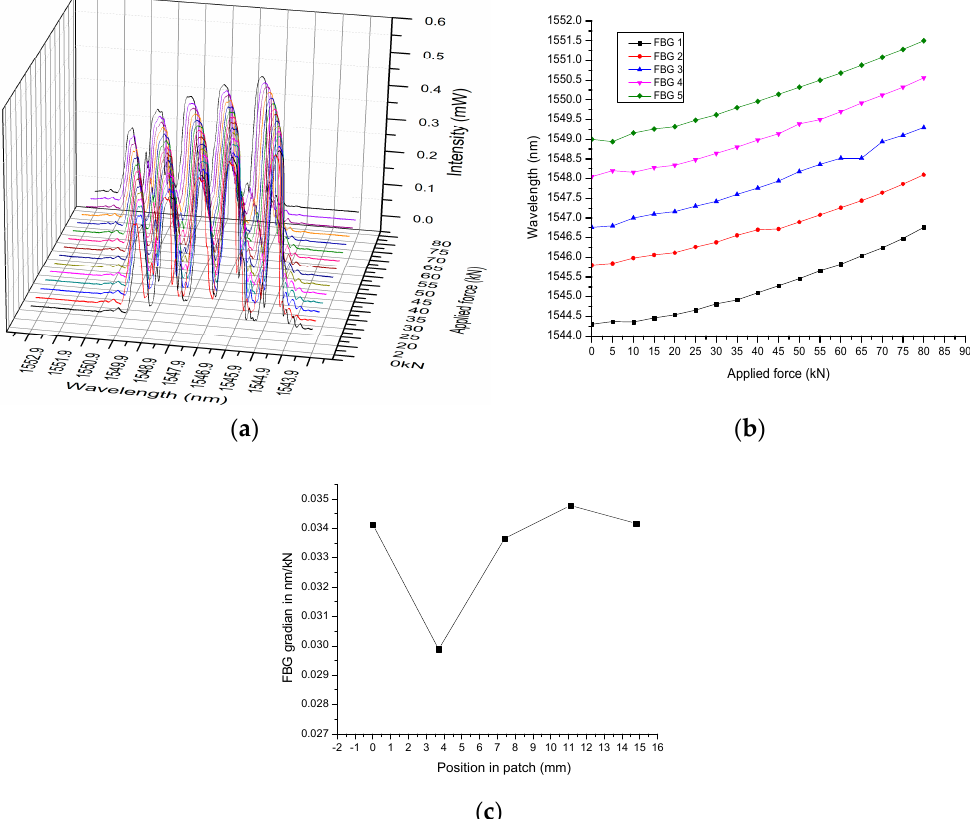
Figure 10. ( a ) Spectral response with applied force of five 1.2 mm FBGs embedded in the composite patch. ( b ) Peak spectral response with applied force for the five FBGs. ( c ) Gradient variation of the five FBGs with proximity to the crack which is located at 7 mm.